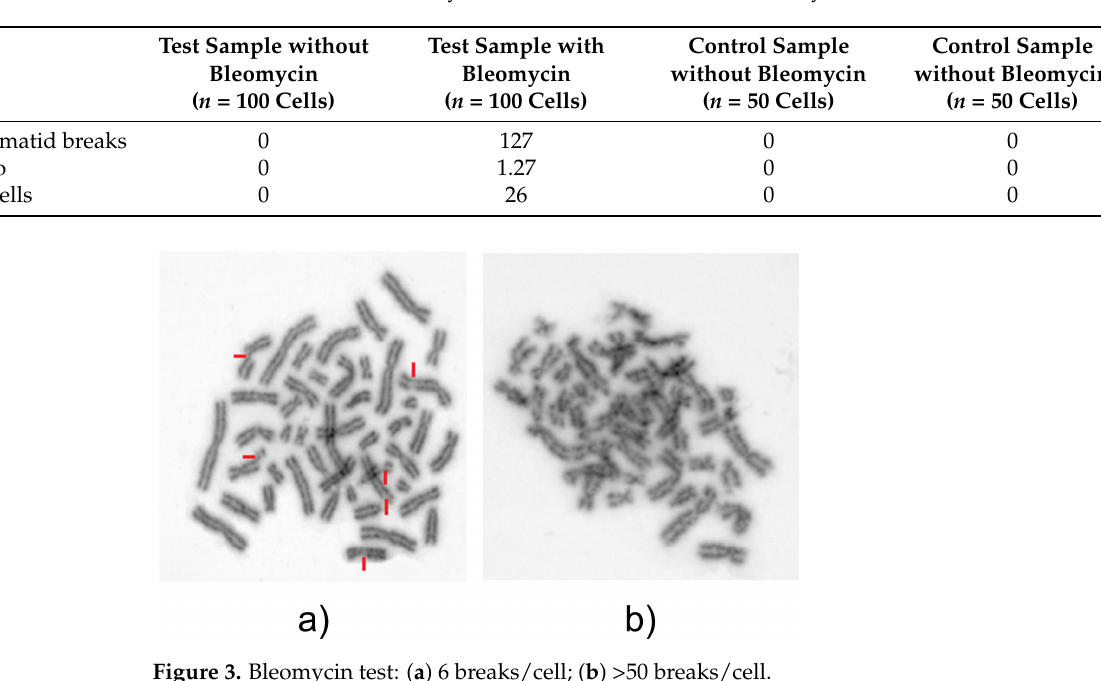
Table 1. Assessment of bleomycin-induced chromosomal instability.